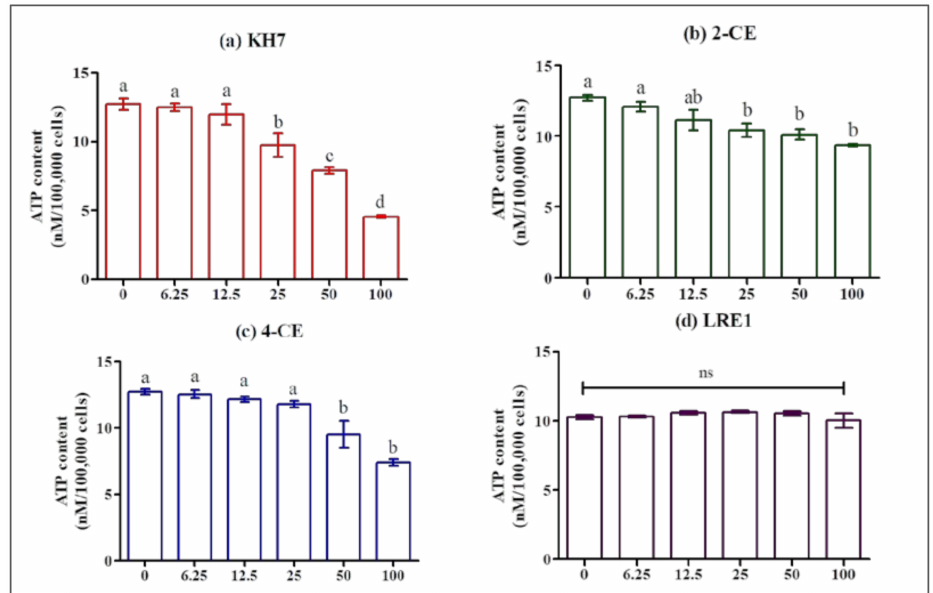
Figure 3. Effect of KH7, 2-CE, 4-CE and LRE1 on the ATP level in MLTC-1 cells. ATP level in MLTC-1 cells was measured after incubation with various concentrations (0, 6.25, 12.5, 50, 100 µ M) of KH7 ( a ), 2-CE ( b ), 4-CE ( c ), or LRE1 ( d ) for 1 h. The experiments were repeated 4 times; values are mean ± SEM. Different letters indicate significant differences between control (0 µ M) and treatment at p < 0.05; ns: not statistically significant.